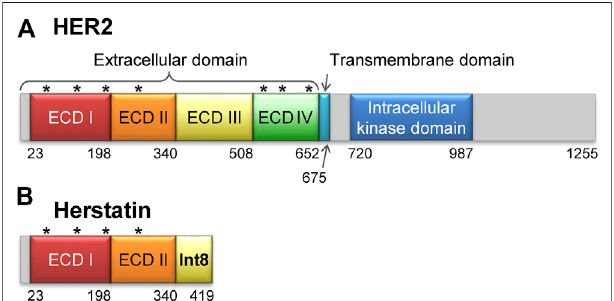
FIGURE 1 | Structures of HER2 and herstatin. (A) Structure of HER2. Theextracellulardomainiscomposedoffoursubdomains,ECDI,ECDII,ECD III, and ECD IV. Seven glycosylation sites are shown by asterisks [N68, N124, N187,N259,N530,N571,andN629 accordingtotheUniProtdatabase (Accession number P04626) (UniProt Consortium, 2021)]. (B) Structure of herstatin. ECD I and ECD II are identical to those in HER2. An intron-8 encoded 79-residue domain, named Int8 (or ECD IIIa), is retained at the C-terminal region of herstatin. Four glycosylation sites identical to those in HER2 are shown by asterisks. Note that Int8 does not have a glycosylation